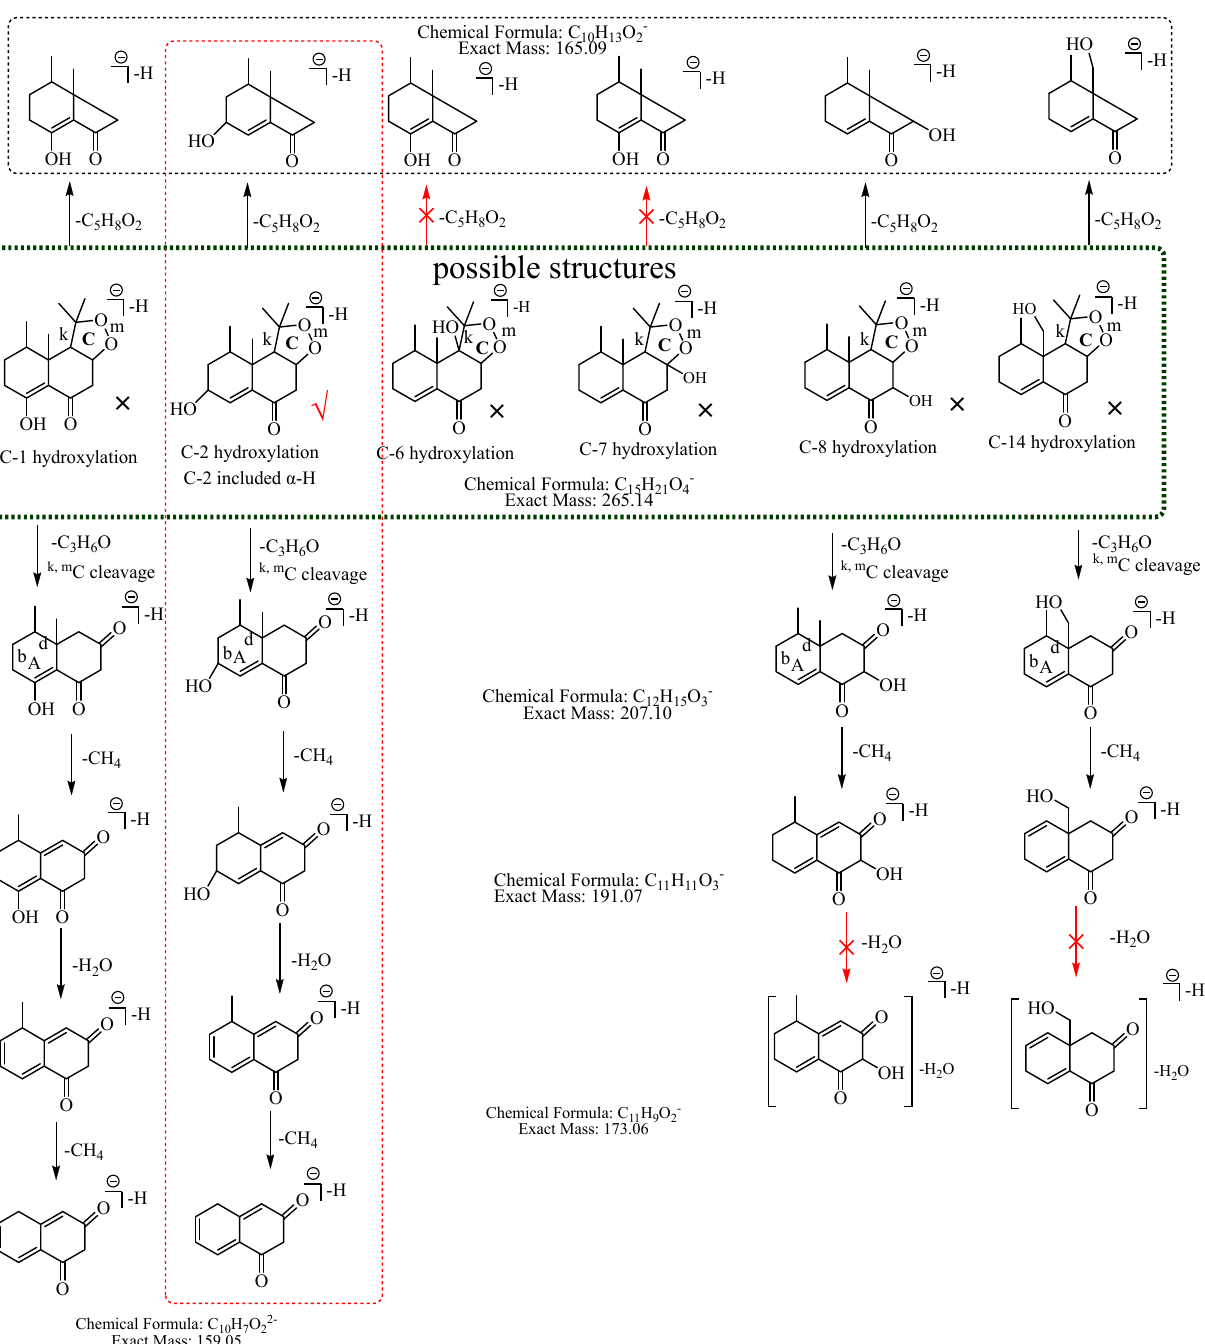
Figure 9. The proposed fragmentation pathways of M7 (2-hydroxyl nardosinone). “ √ ” represents the possible structure. “ × ” represents the impossible structure. The atrovirens rim represents the possible structures; A and C represent the hexatomic rings. The red rim represents the most possible fragmentation pathway.